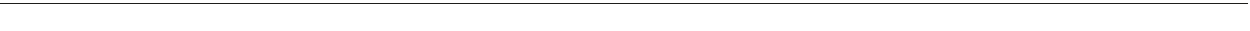
Fig. 2 Altered alveologenesis in PC-speci fi c Yap1 and Wwtr1 mutant mice. a Three-dimensional reconstruction confocal images of Yap1 , Wwtr1 iPCKO and littermate control lungs stained for AQP5 (green), PDGFR β (red), and PECAM1 (blue) at the indicated stages. Scale bar, 50 µ m. b Quantitation of airspace volume in Yap1 , Wwtr1 iPCKO and control lung sections with three-dimensional reconstruction surface images. Data represents mean ± s.e.m. ( n = 4 mice; unpaired two tailed student t -test or Welch ’ s t -test) c Lung volume measurement of Yap1 , Wwtr1 iPCKO and littermate control lungs at the indicated stages. Data represents mean ± s.e.m. ( n = 5 for P7, n = 7 for P12, n = 7 for P18 controls, n = 5 for P18 mutant mice, two-tailed unpaired t -test). d Representative fl ow cytometry plots of EdU incorporation in EpCAM + cells from P7 Yap1 , Wwtr1 iPCKO and littermate control mice. e Diagrams showing fl ow cytometry cell cycle analysis of CD31 + or EpCAM + cells in P7 Yap1 , Wwtr1 iPCKO and littermate control lungs. Data represents mean ± s.e.m. ( n = 8 mice, NS: not signi fi cant, Unpaired two tailed student t -test or Welch ’ s t -test). f Three-dimensional reconstruction confocal images of P7 Yap1 , Wwtr1 iPCKO and littermate control lungs stained for SFTPC (green), EdU (red), and DAPI (blue). Quantitation of EdU positive and SFTPC positive cells is shown on the right. Data represents mean ± s.e.m. ( n = 4; unpaired two tailed student t -test). Scale bar, 30 µ